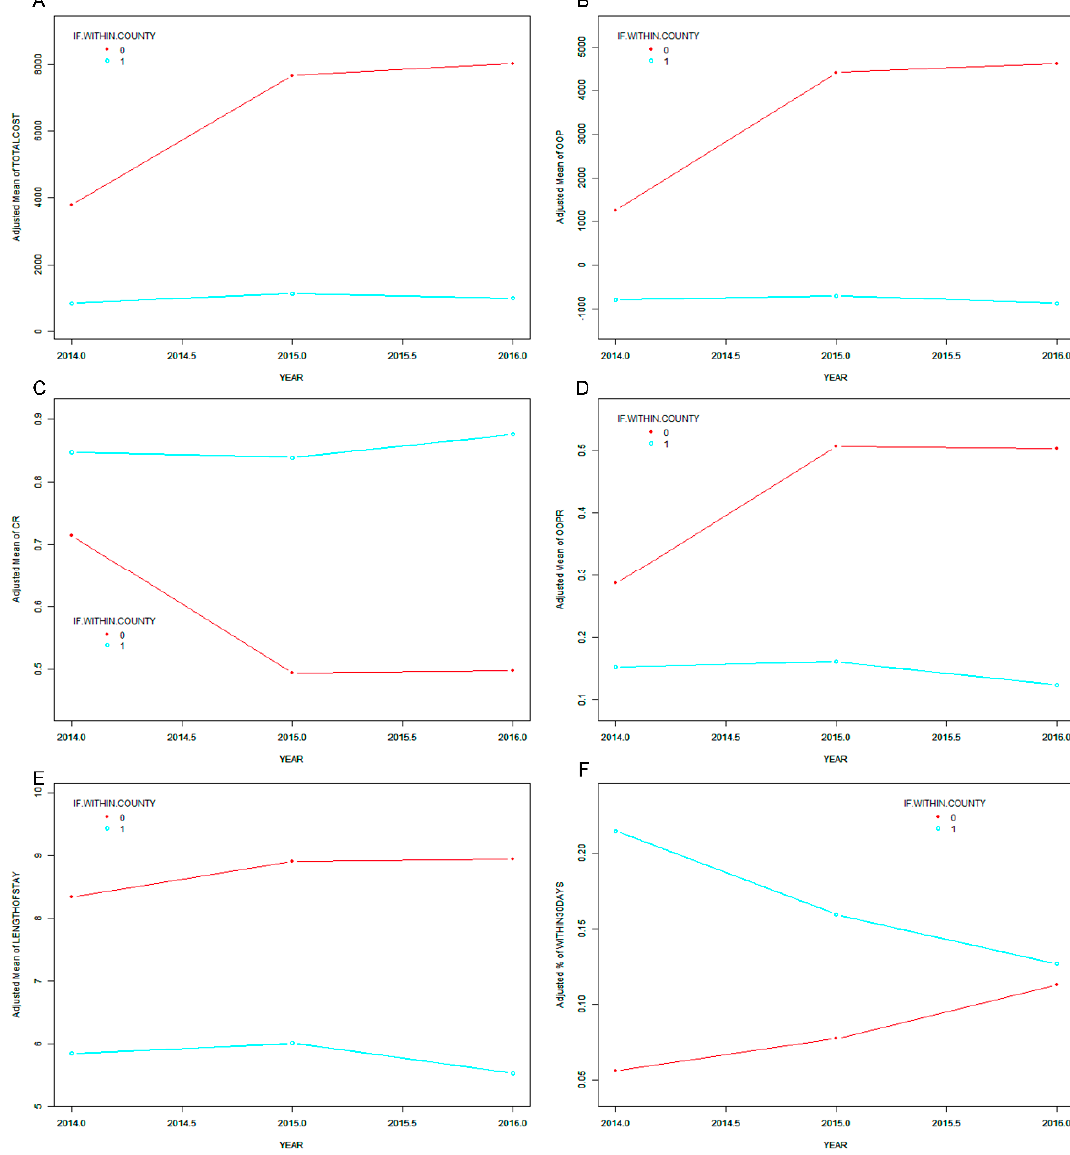
Figure 2. Direct economic burden and service quality for cerebral infarction inpatients within and outside the county (0: out of the county, 1: within the county). Ordinate: ( A ) adjusted mean of total costs; ( B ) adjusted mean of OOP expenditures; ( C ) adjusted mean of CR; ( D ) adjusted mean of the OOP ratio; ( E ) adjusted mean of length of stay; ( F ) adjusted mean of the R30 rate.